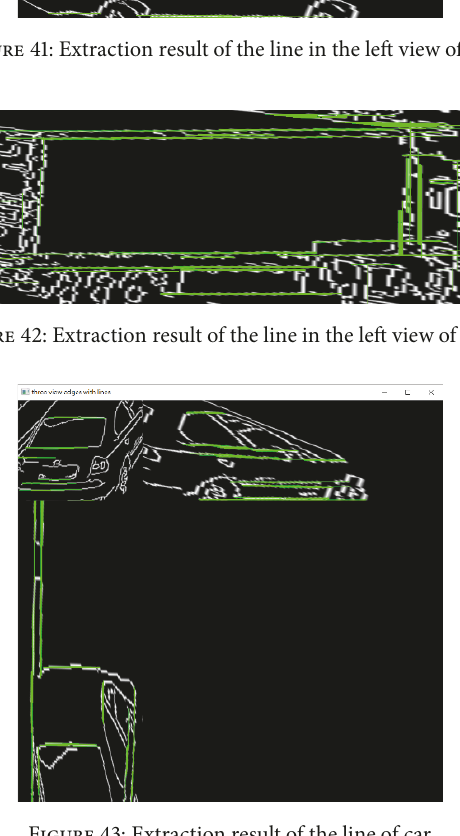
Figure 43: Extraction result of the line of car.